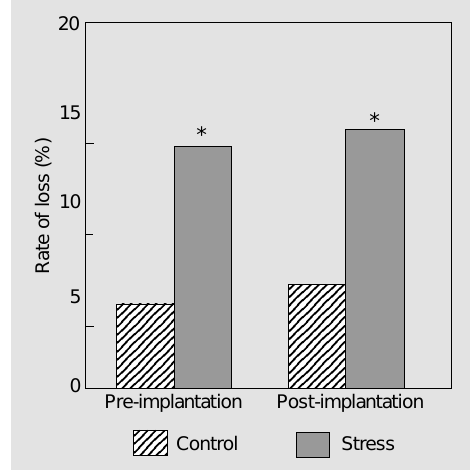
Figure 2 - Rates of pre-implanta- tion and post-implantation loss in normal females mated with control and stressed adult